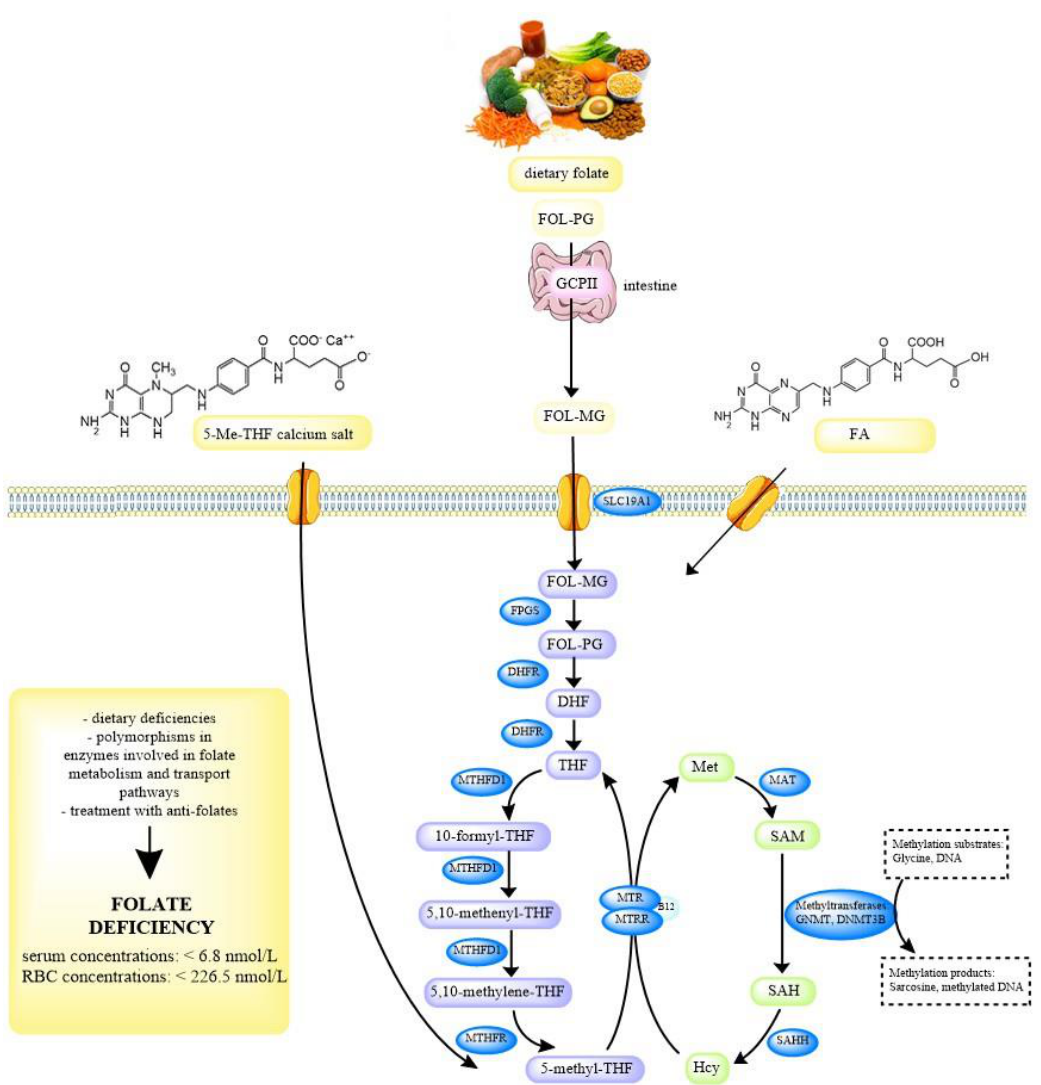
Figure 1. Overview of folate-homocysteine metabolism pathway and possible causes of folate